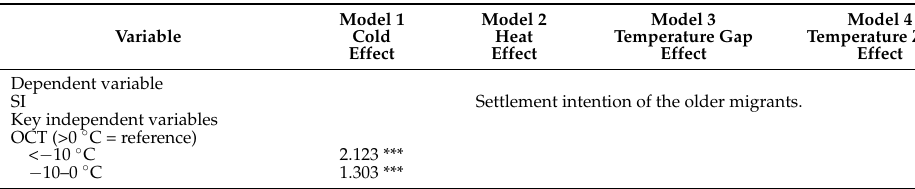
Table 2. The results of odds ratio in the binary logistic